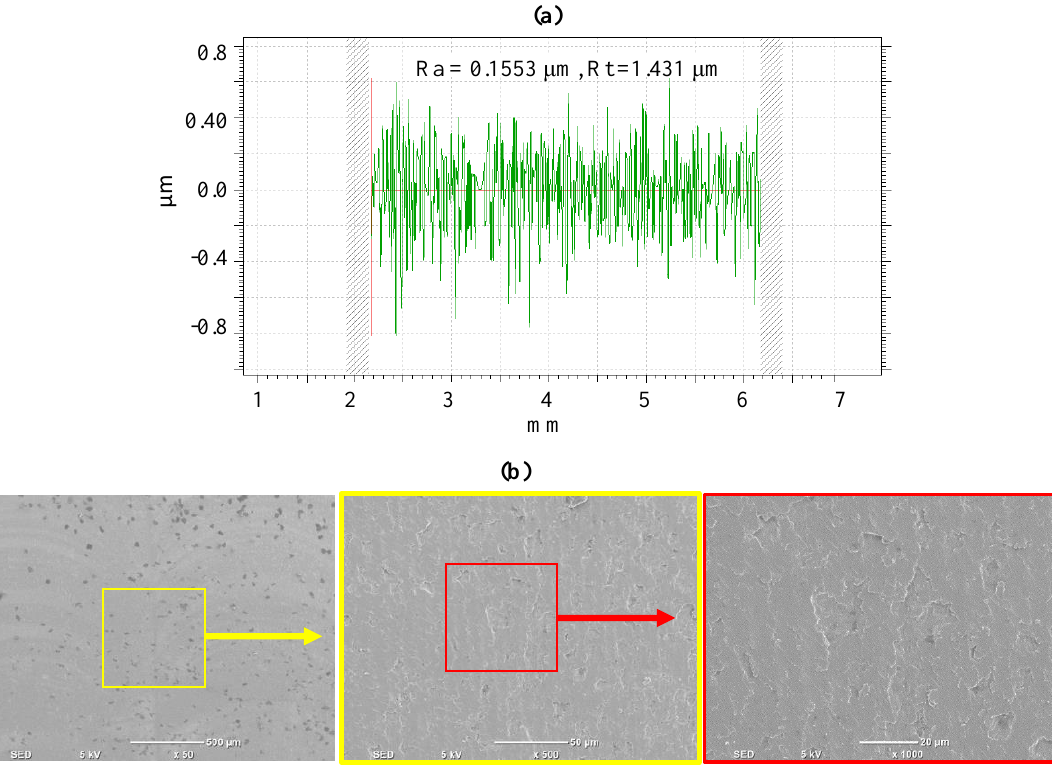
Figure 14. ( a ) Typical example of surface roughness profile and ( b ) surface morphology of the pocket machined with Mix-2 strategy.